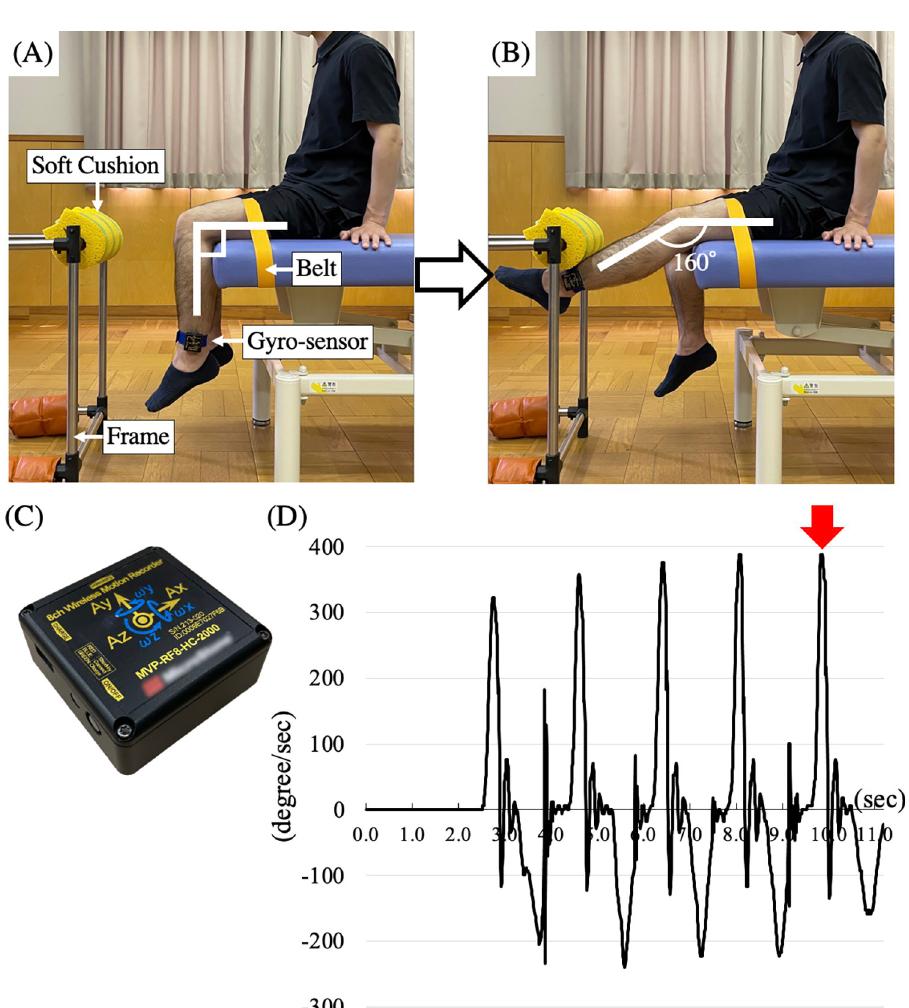
Fig 1. Measurement of the maximum knee extension velocity. (A, B) Experimental setup for measurement. The patient was seated on an elevated bed with a wireless gyro-sensor, where they extended their knee joint five times as quickly as possible from 90˚(A) to 160˚(B) to hit the soft cushion. (C) The gyro-sensor. (D) Representative data of knee extension velocity. The red arrow indicates the maximum knee extension velocity of five times.